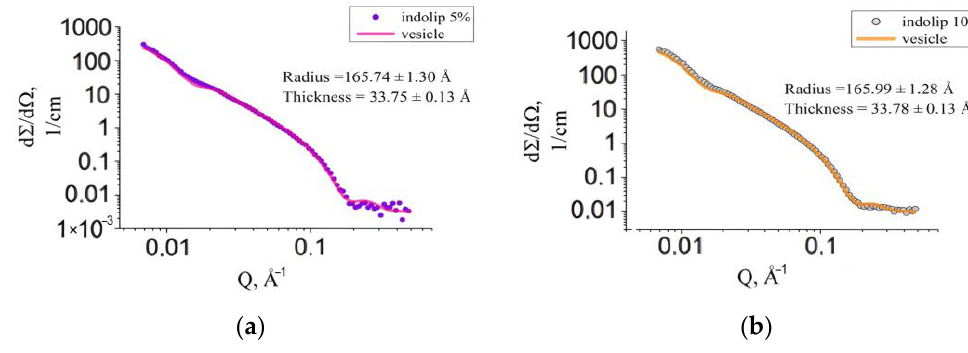
Figure 4. Experimental scattering curve of the Indolip sample with a concentration of 5% ( a ) and 10% ( b ) and the approximation function describing vesicles.